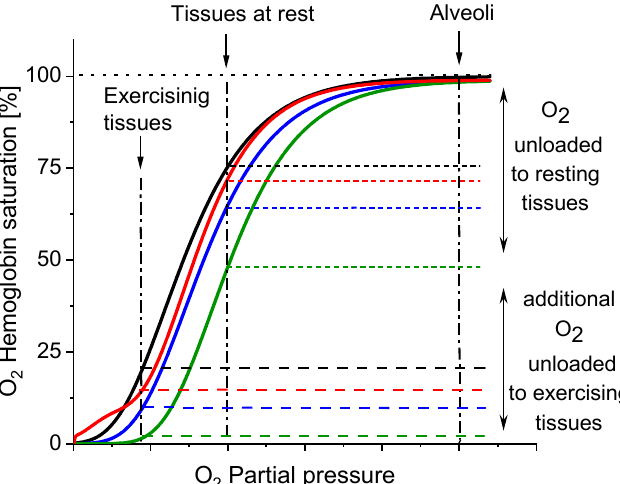
Figure 5. Direction of changes in Hb-O 2 affinity as a result of β -Crt impact on RBCs. The oxy- haemoglobin dissociation curves (ODCs) are based on the theoretical evaluation of OxyHb saturation changes observed in the time dependent Mössbauer experiments (see: Figure 3c,d and Figure 4). Labels: control (black), RBCs 50 (blue), RBCs 100 (green), RBCs 500